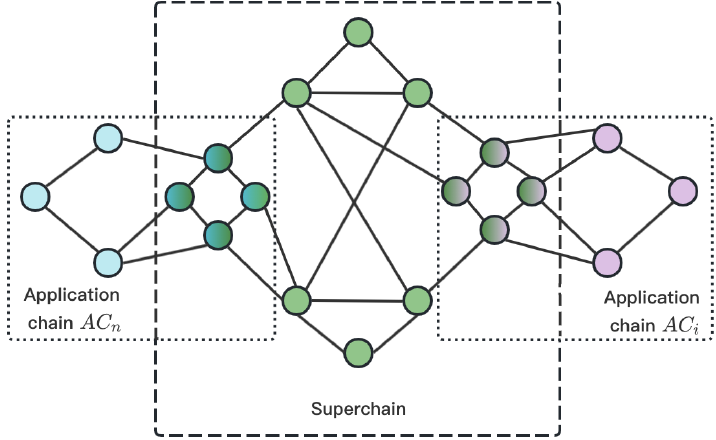
Figure 2. The network of the cross-chain